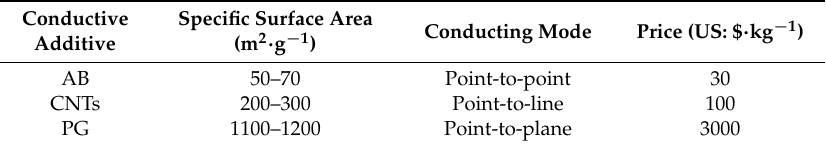
Table 3. Comparison of different conductive additives in LiMn 2 O 4 cathode of the ReHAB